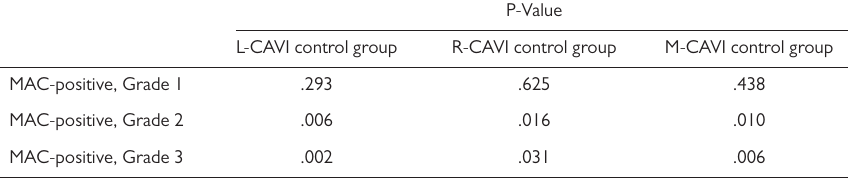
Table 3. Results of Post-Hoc Analysis to Determine the Differences Between Control and MAC-Posi- tive Groups Originated From MAC